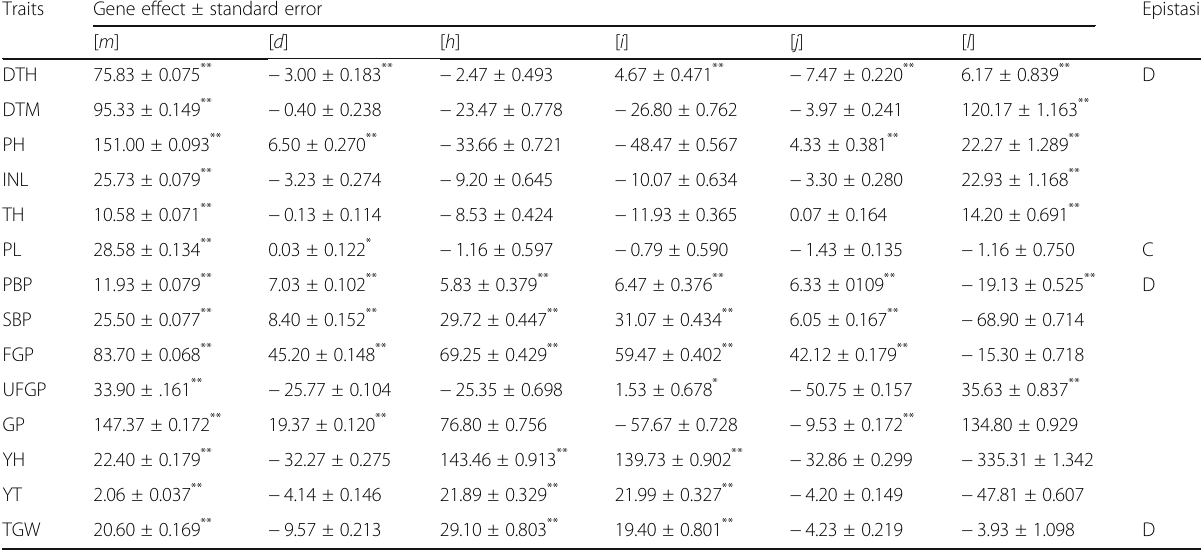
Table 4 Estimation of component of generation means for different traits in submergence tolerant rice